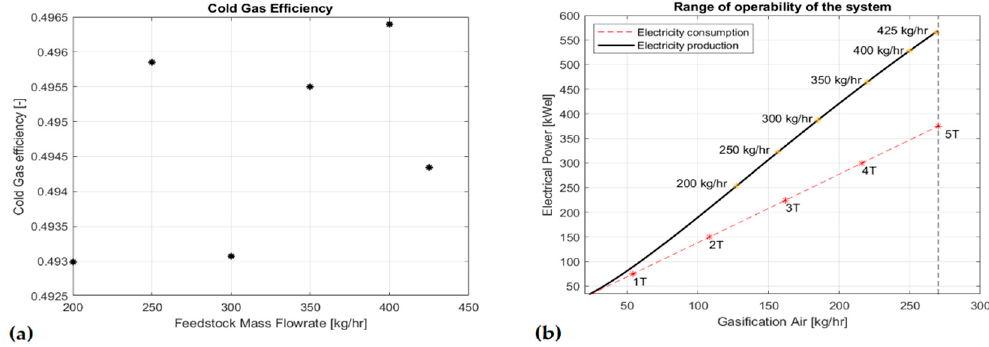
Figure 8. ( a ) Cold gas efficiency as a function of the feedstock mass flow rate; ( b ) Electrical power as a function of .